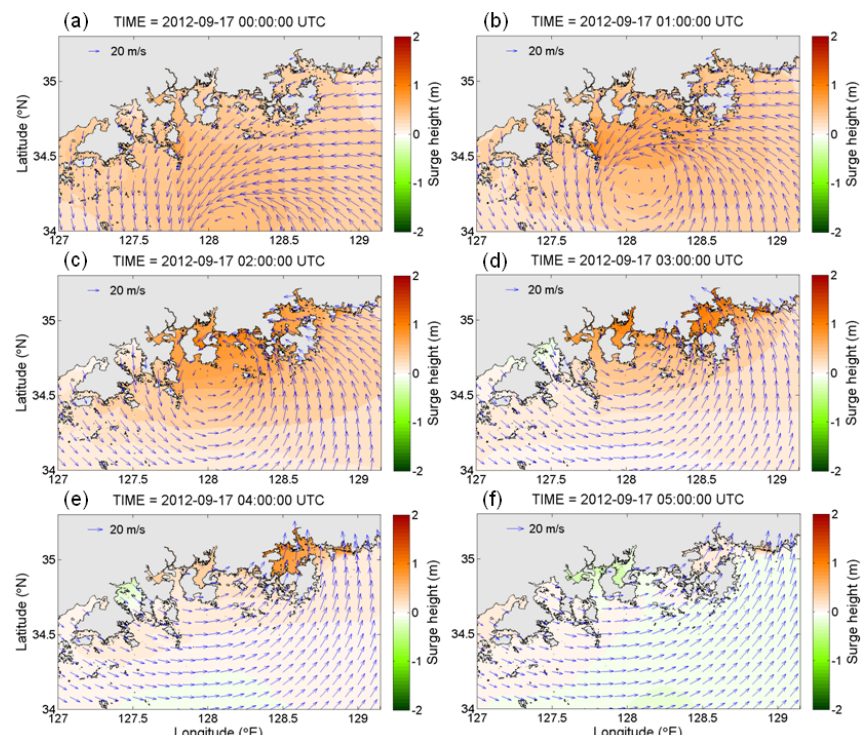
Figure 11. Storm surge and wind field distributions during typhoon landfall, contours denote the storm surge height and vectors denote the wind speed and